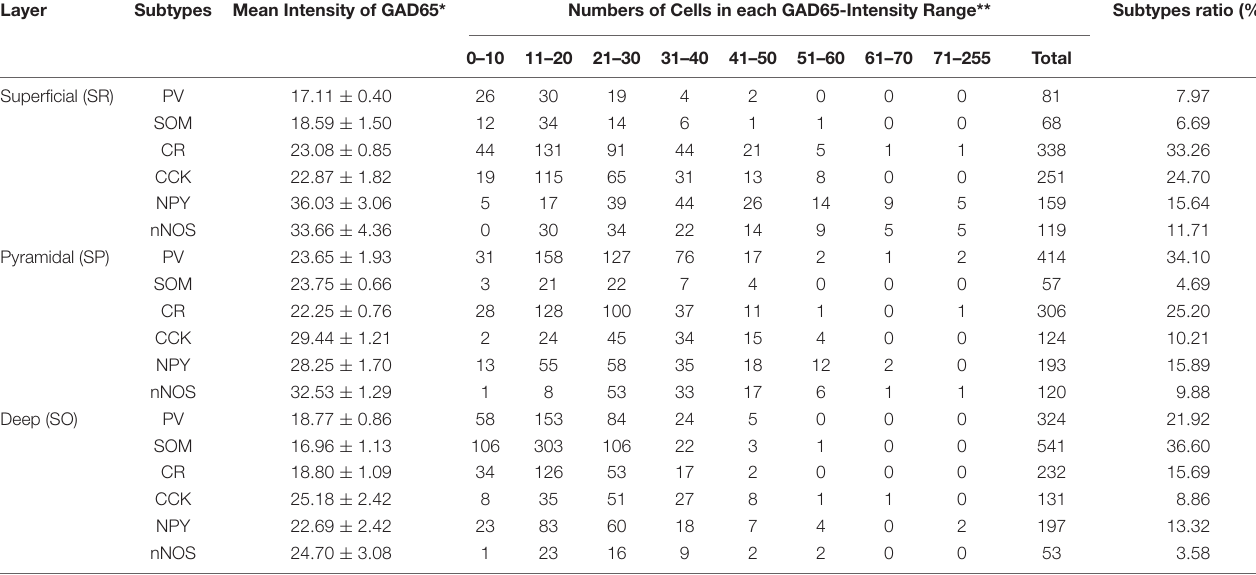
TABLE 2 | GAD65 Expression in Hippocampal Layers Based on GAD65 Staining Intensity. Layer Subtypes Mean Intensity of